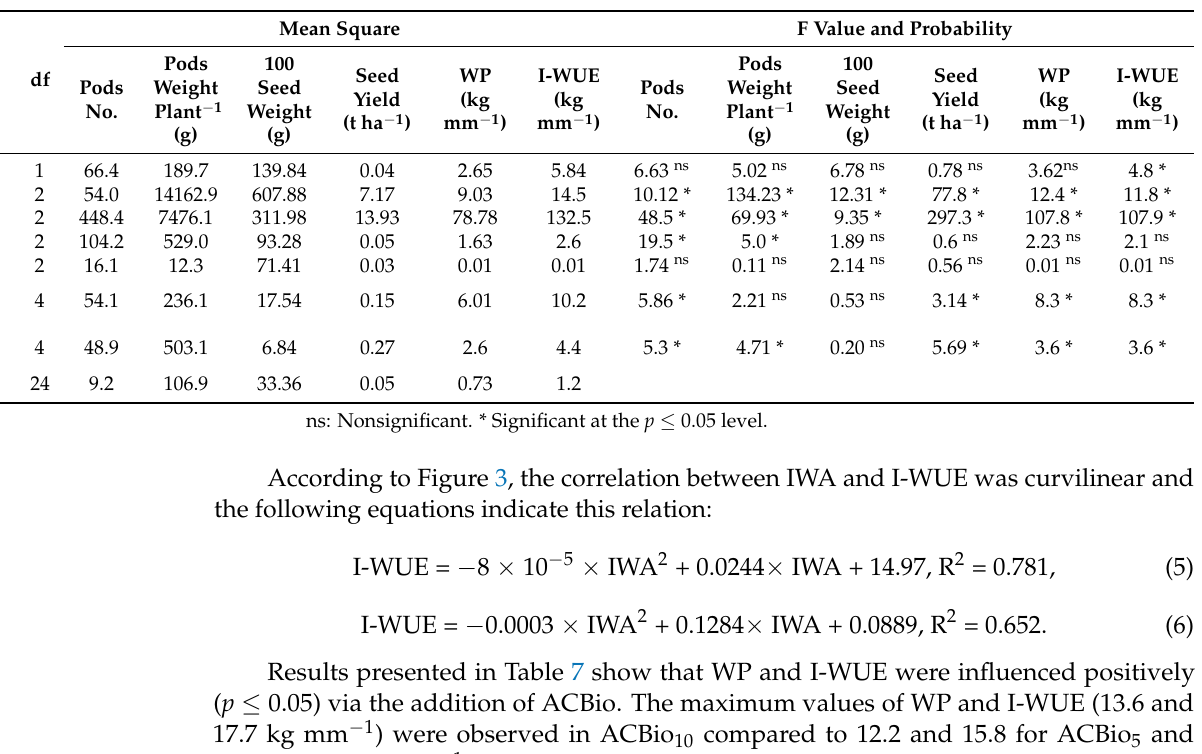
Table 8. Mean square, F value, and probability for pod number, pod weight plant − 1 , 100 seed weight, seed yield, water productivity (WP), and irrigation water use efficiency